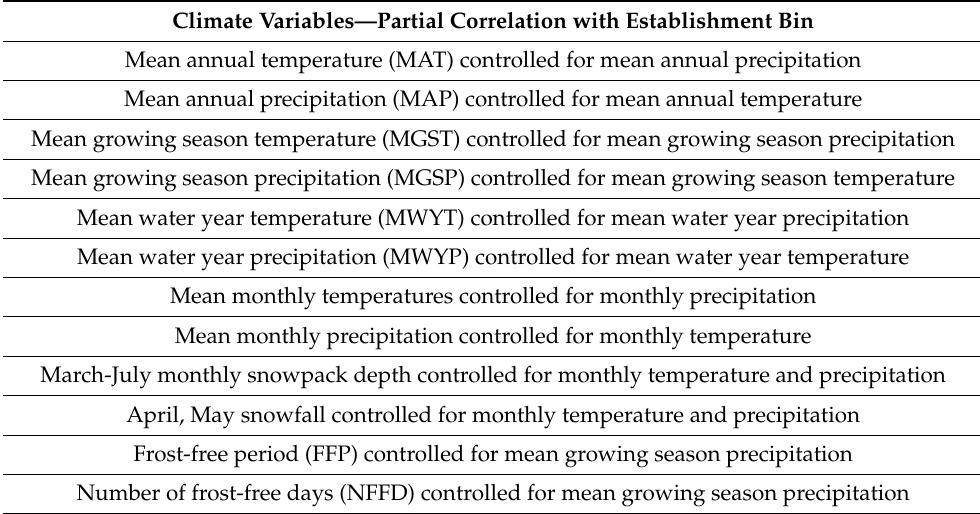
Table 2. Climate variables used in partial correlation analyses with number of trees established in each 5-year bin. The growing season is defined as the months of May through September. Climate Variables—Partial Correlation with Establishment